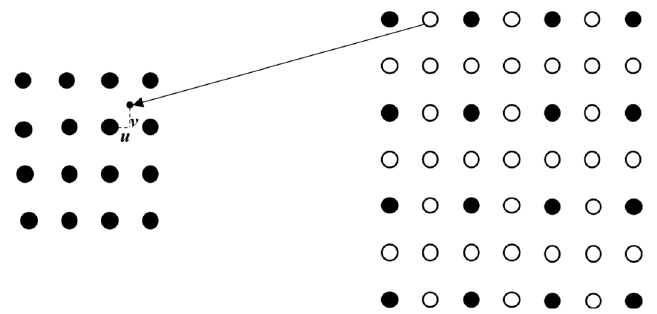
Figure 6. Bicubic interpolation mapping.